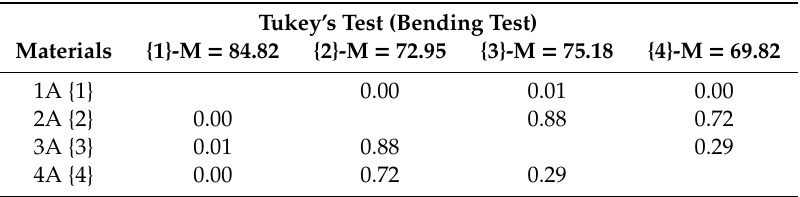
Table 5. Tukey’s test